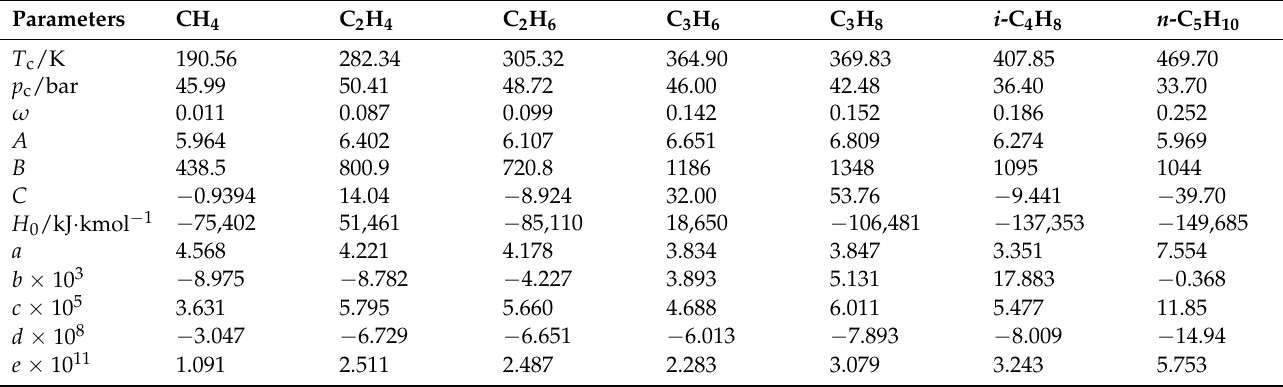
Table A2. Thermodynamic parameters of each